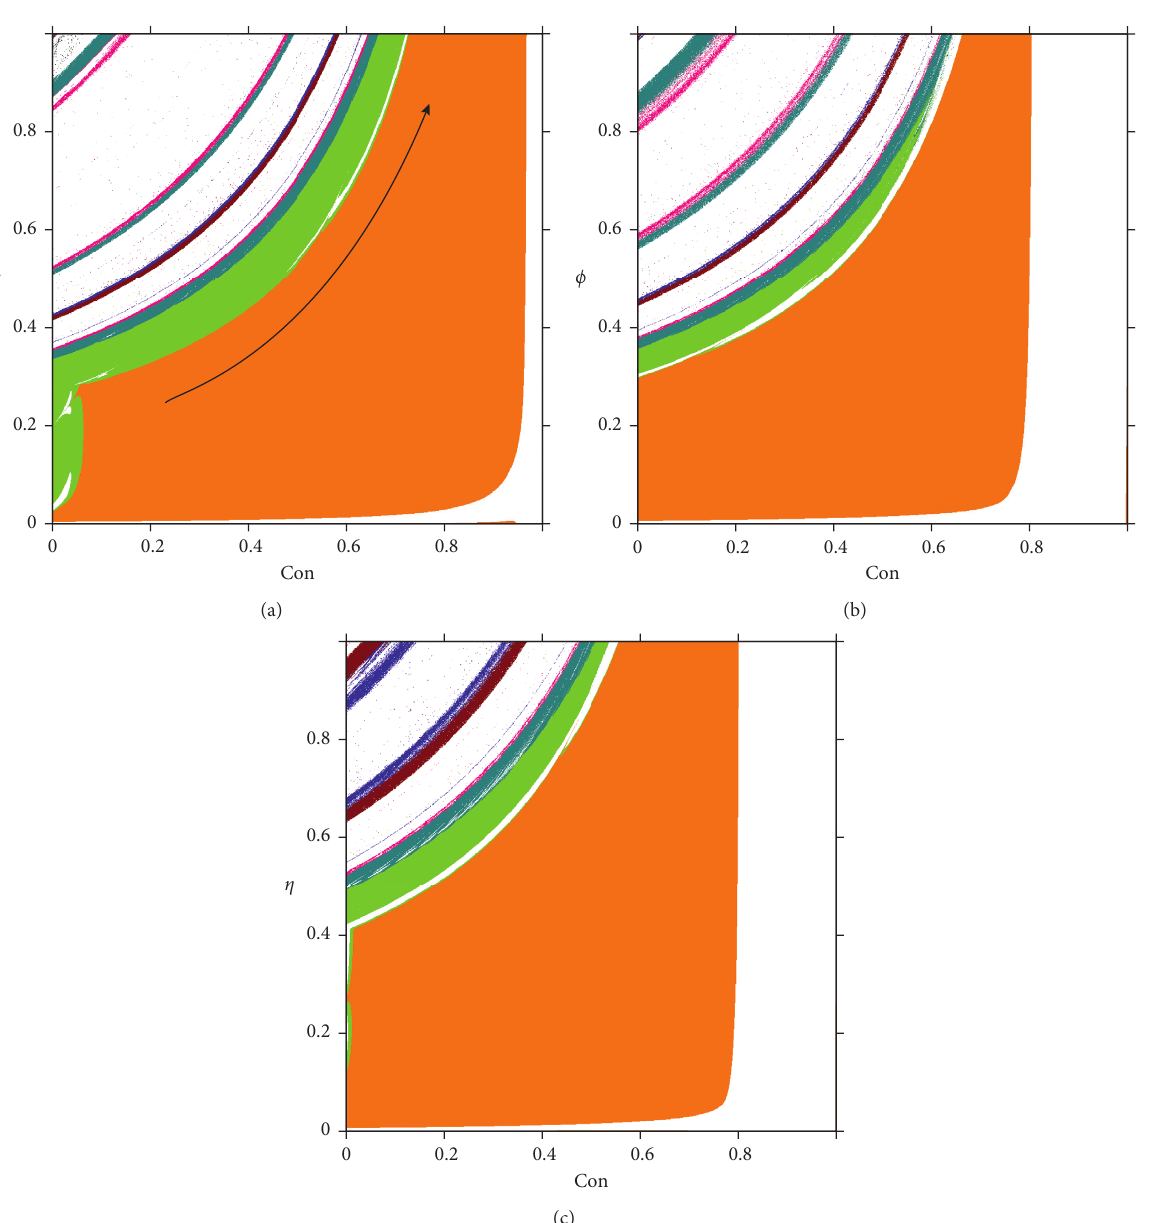
Figure 8: The basin of parameter under control. (a) The basin of Con and ε . (b) The basin of Con and ϕ . (c) The basin of Con and η